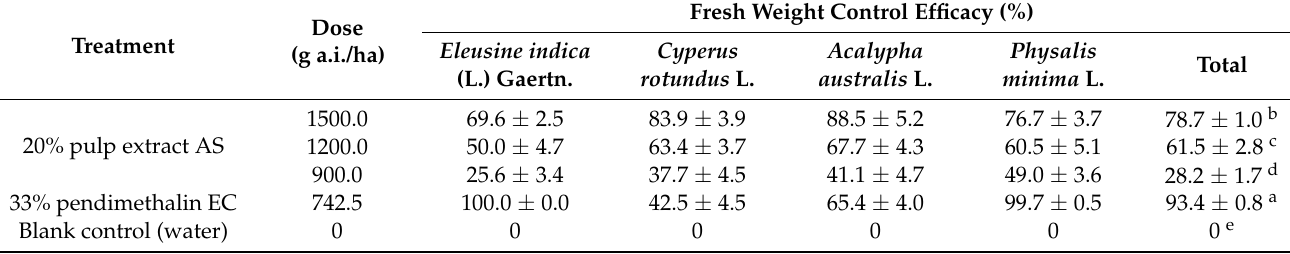
Table 3. Control efficacy of 20% pulp extract AS and pendimethalin EC against the weed fresh weight in carrot at 45 days after treatment. Data presented are the mean of three replicates ± standard deviation (SD). “Total” represents the fresh weight control efficacy for all weeds in carrot